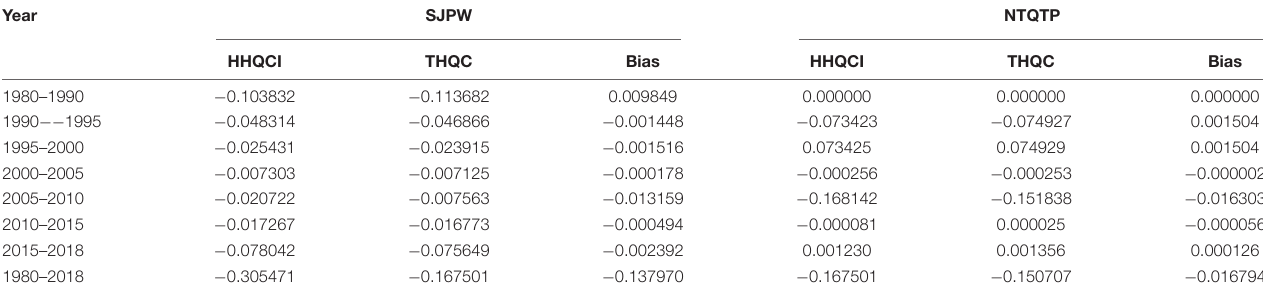
TABLE 3 | Human-induced land-use changes from 1980–2018 (units: km 2